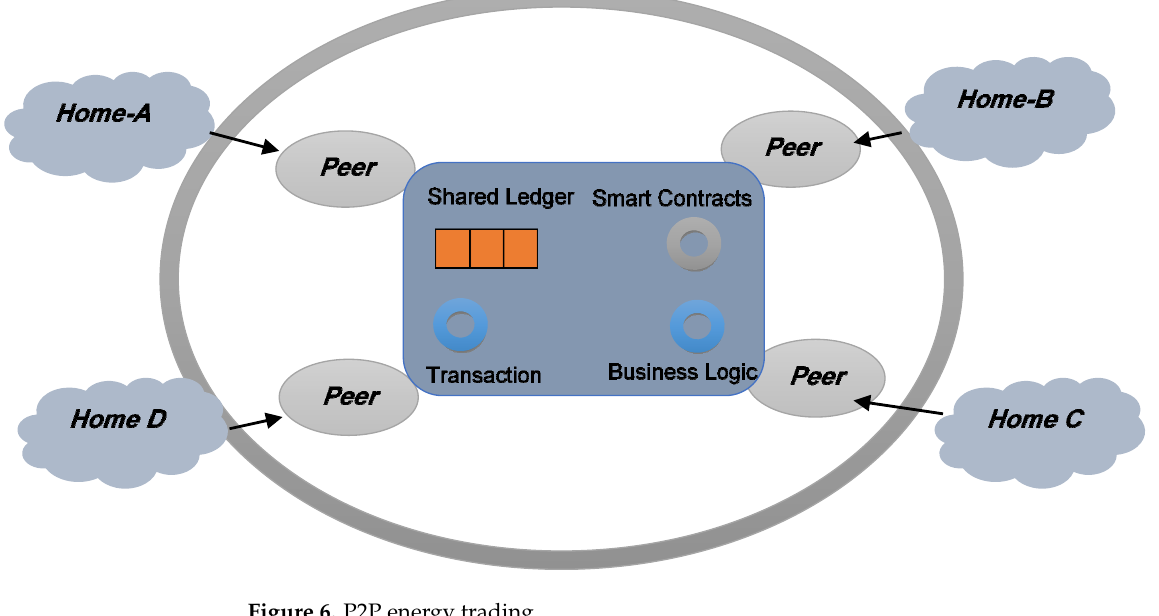
Figure 6. P2P energy trading.